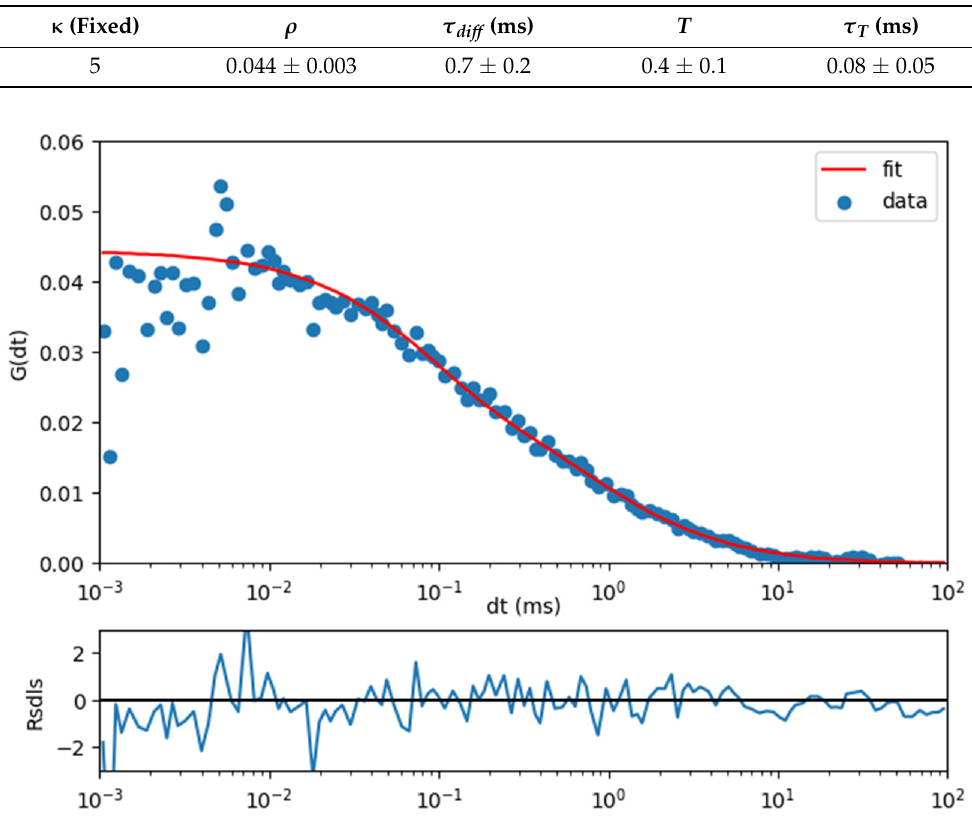
Figure 1. An autocorrelation curve for a triplet model for red SAASoti.